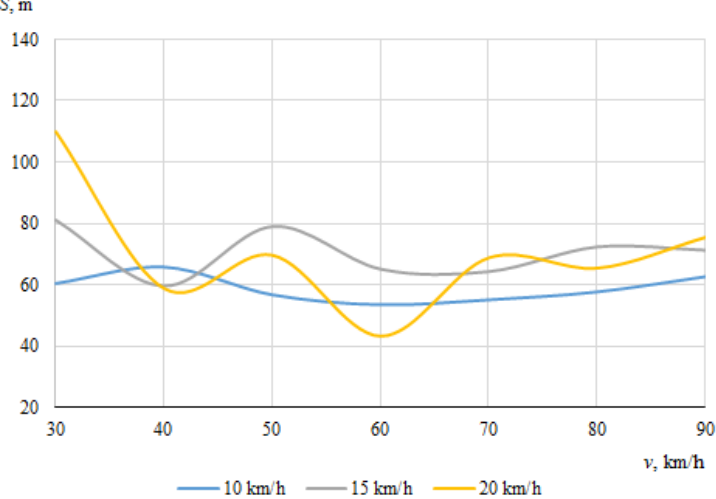
Figure 7. Throwing distances of the cyclist (impact angle 0°).